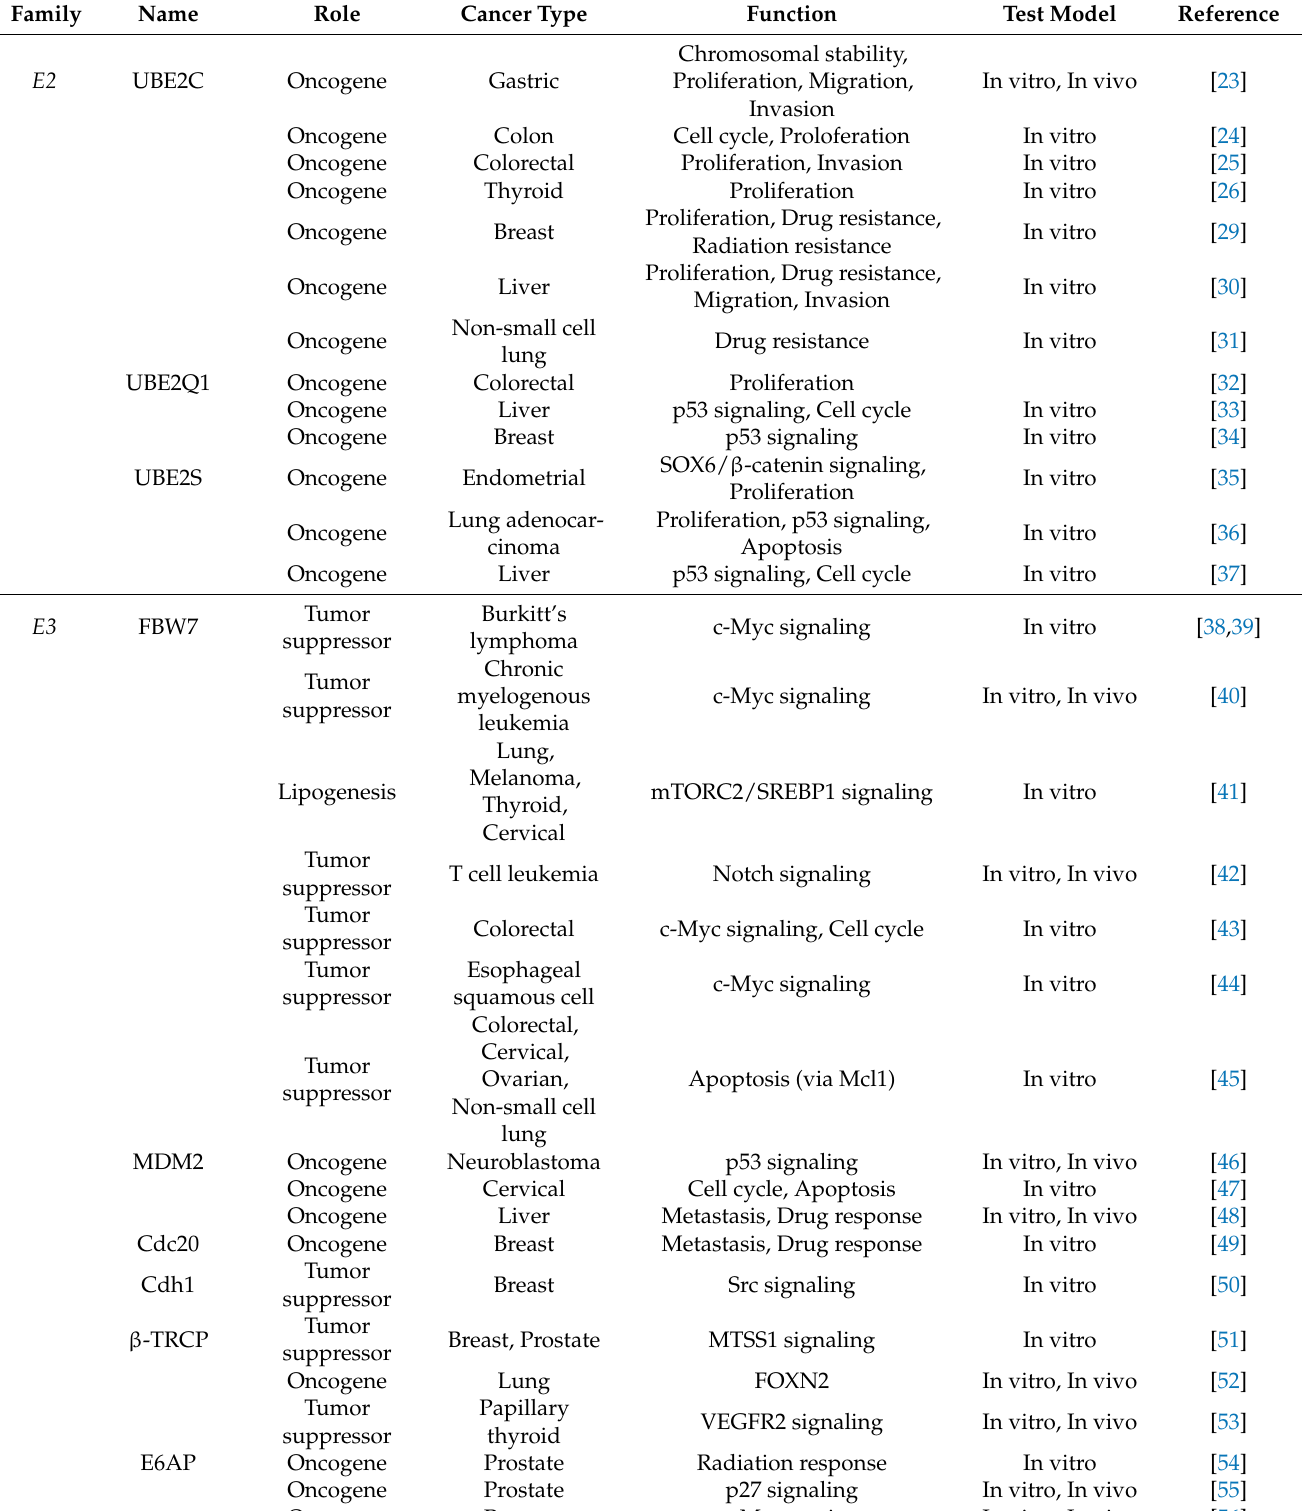
Table 1. Summary of the functions of E2 and E3 enzymes in human cancers described in this review.